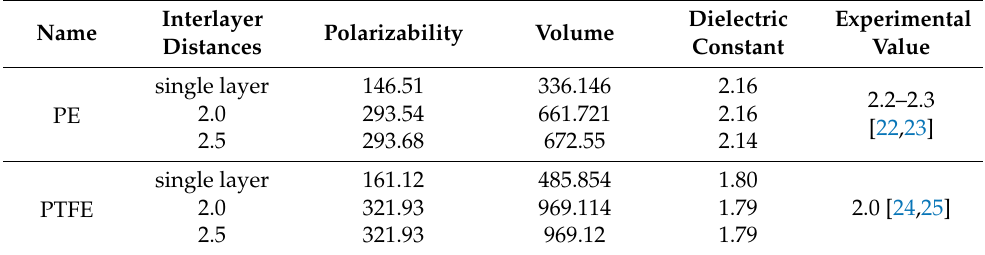
Table 3. The simulated dielectric constants of the single- and double-layer polymer chains for PE and PTFE. Here, the units of interlayer distance, polarizability, and volume are Å, a 03 , and Å 3 ,